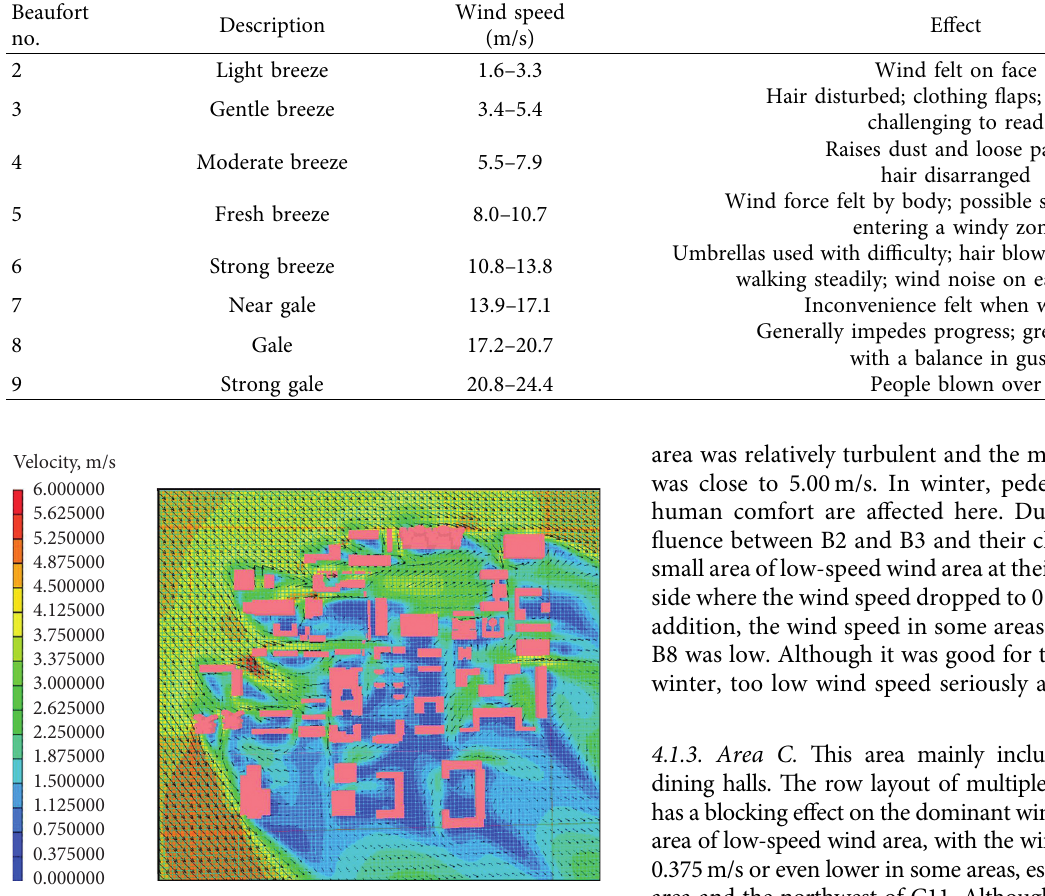
Figure 11: The wind velocity vector illustration at Z � 1.5m in winter.